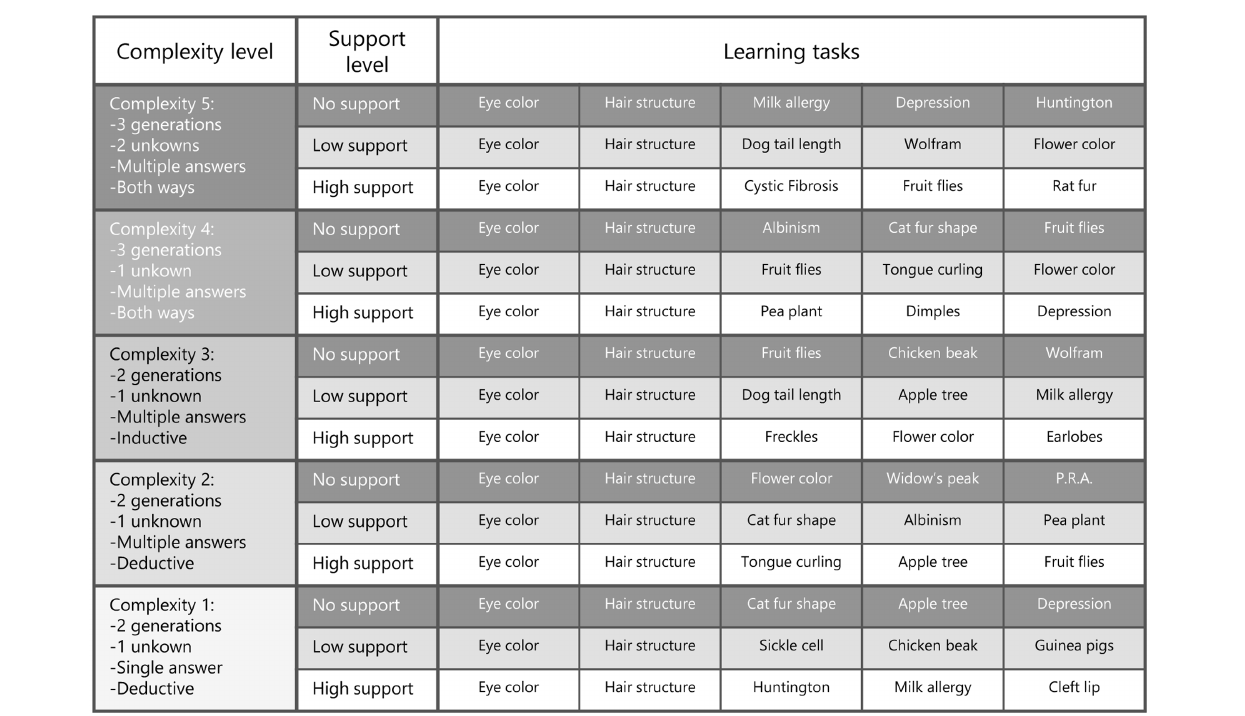
performed (assuming that monitoring and regulation processes would approach actual performance and are more or less